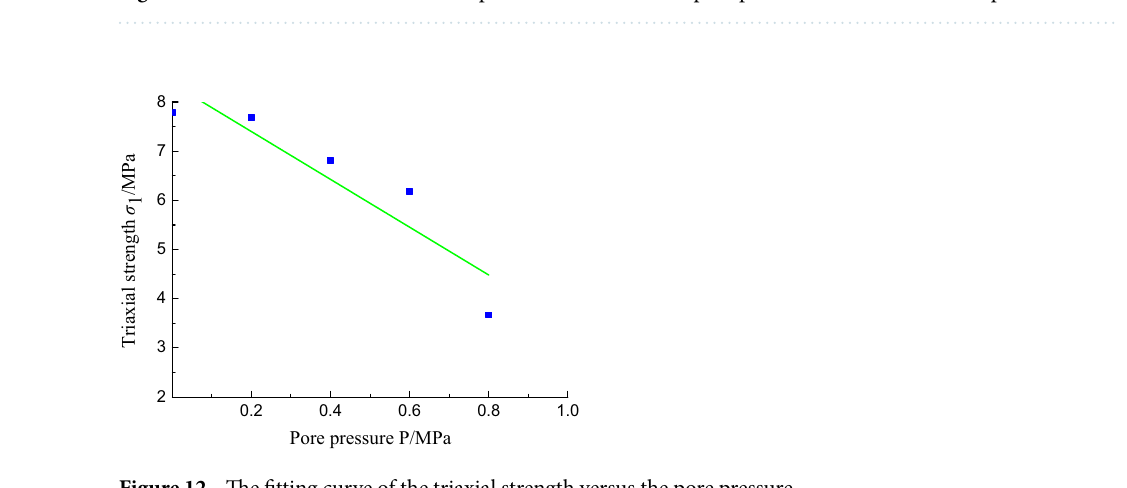
Figure 11. Stress–strain curves of coal specimens with different pore pressures under triaxial compression.